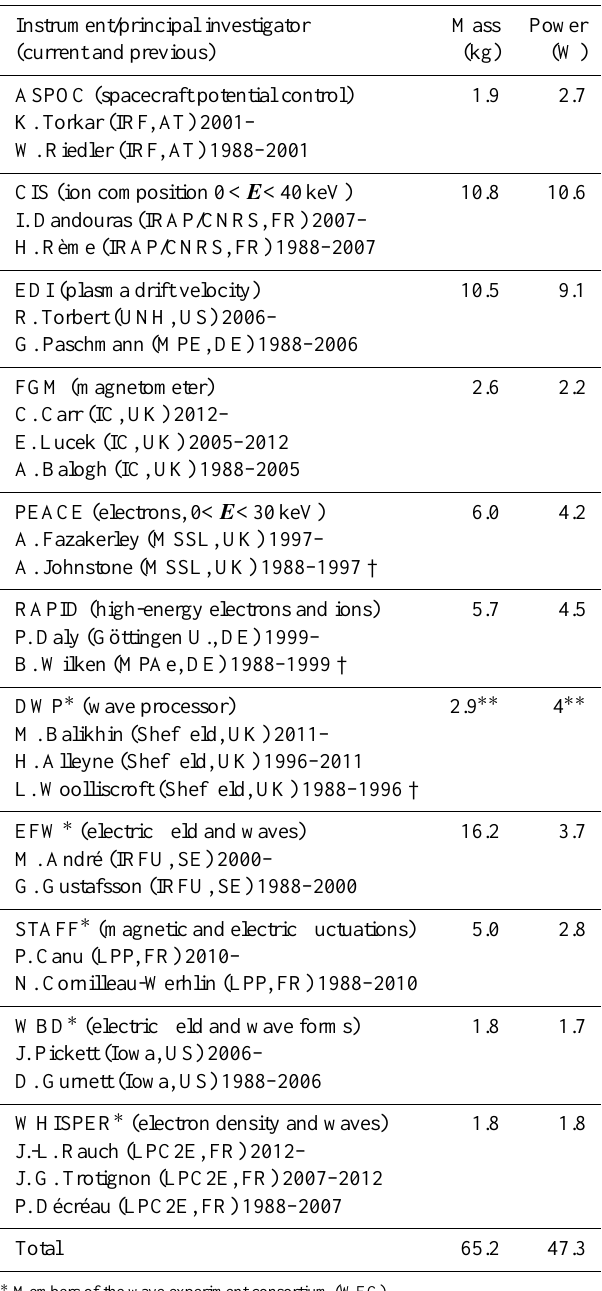
Table 1. The 11 instruments on each of the four Cluster spacecraft. History of PIs is also